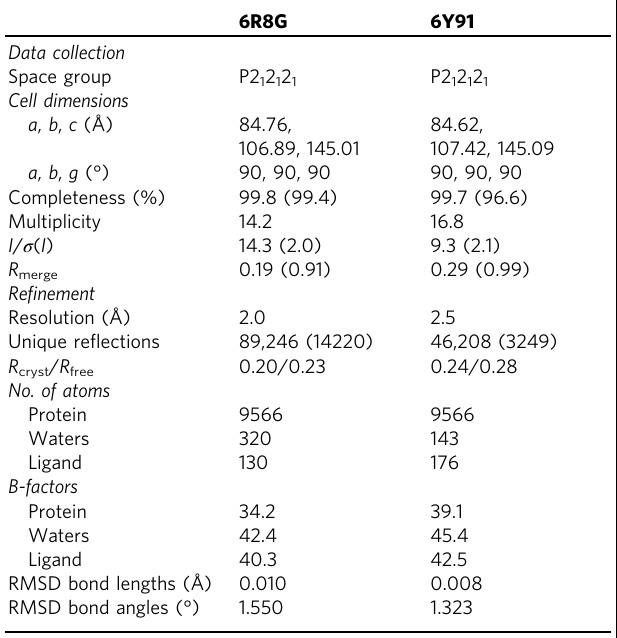
Table 1 Data collection and re fi nement statistics.